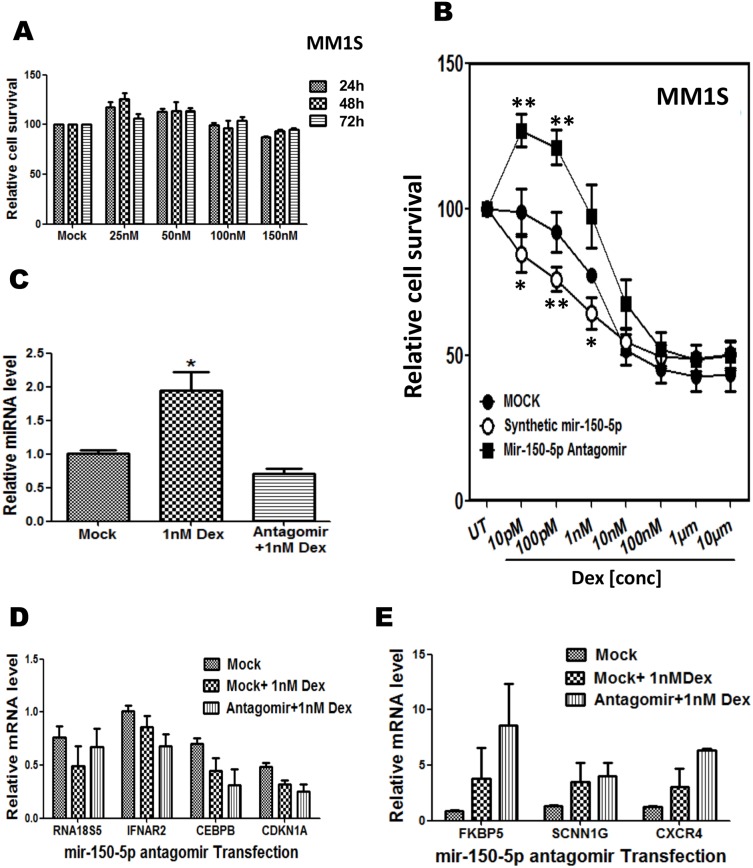
Weak sensitisation of low dose GC therapy response by mir-150-5p mimetic transfection can be reversed by transfection of a mir-150-5p-specific antagomir in MM1S cells.(A) MTT based quantification of MM1S cell survival, following 24, 48, or 72 h transfection with increasing doses of synthetic mir-150-5p mimetic as compared to mock transfection control (B) MTT based quantification of MM1S cell survival, following 72 h treatment with increasing doses of Dex, in combination with either mock transfection, else transfection with a synthetic mir-150-5p mimetic or mir-150-5p specific antagomir (as indicated in figure). Data represented are relative cell survival levels (mean ± SEM) of three independent experiments. Means with ***, **, * are significantly different (p<0.001, <0.01 or <0.05) from control setup as determined by two-way ANOVA (Bonferroni posttests). (C) Realtime quantitative PCR (QPCR) quantification of mir-150-5p transcription levels following 72 h treatment with 1 nM Dex, either or not in combination with transfection of a mir-150-5p specific antagomir. (D–E) Illumina BeadChip Gene Expression results of a subset of genes are presented as bargraphs, reflecting the mean fold change from three independent experiments of MM1S cells treated for 72 h with 1 nM Dex vs. control setup, either or not in combination with transfection of a mir-150-5p specific antagomir.